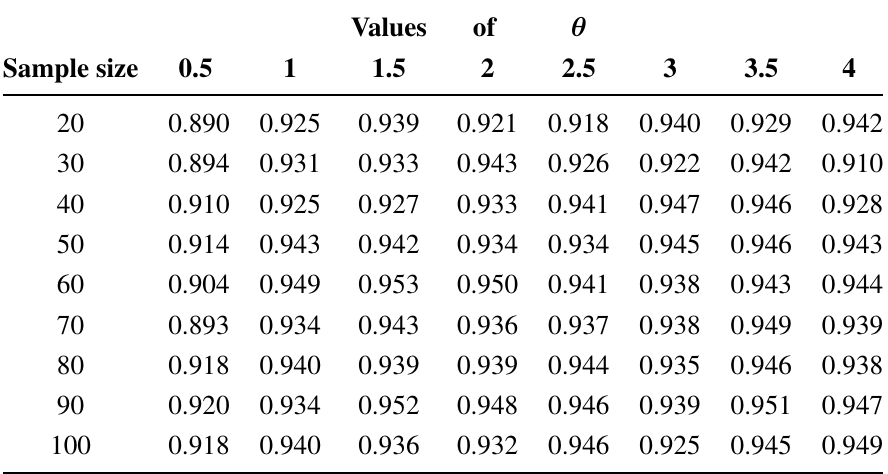
Table 2. Estimated coverage probability of the bootstrap 95% confidence intervals for the mean parameter, µ , using the percentile method.